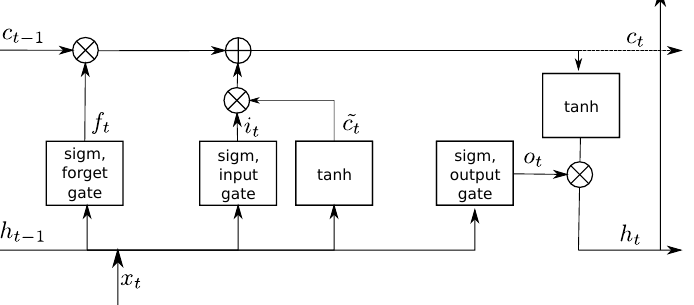
Figure 3. Structure of LSTM memory block: x t is an input signal at the time t , c t − 1 and c t represent cell states at the previous t − 1 and actual t times, h t − 1 and h t are output signals of the cell at t − 1 and t times, b represents the bias. The symbol × represents the multiplication and + summation of